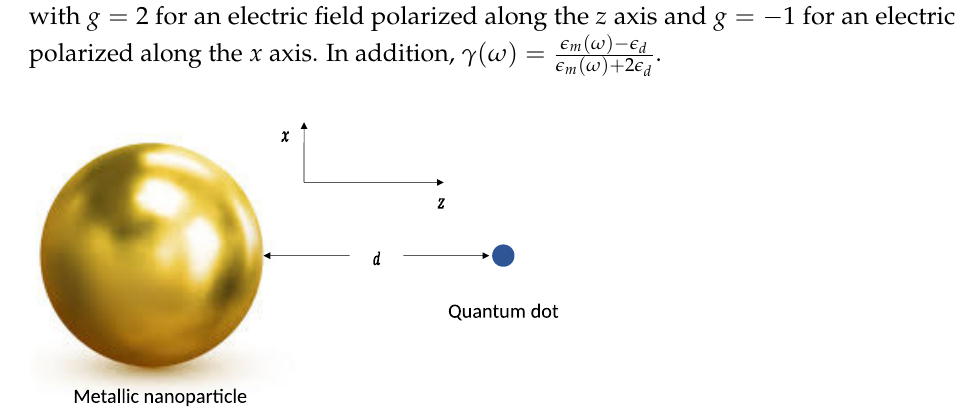
Figure 1. The schematic of the system under study. A quantum dot is placed at distance d away from the surface of a metallic